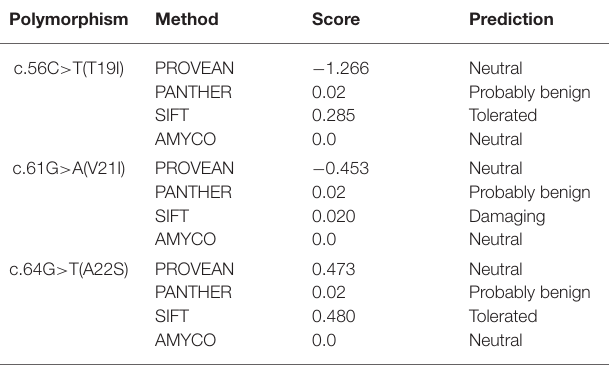
TABLE 5 | In silico evaluation on effect of nonsynonymous single nucleotide polymorphisms in the quail prion protein gene ( PRNP